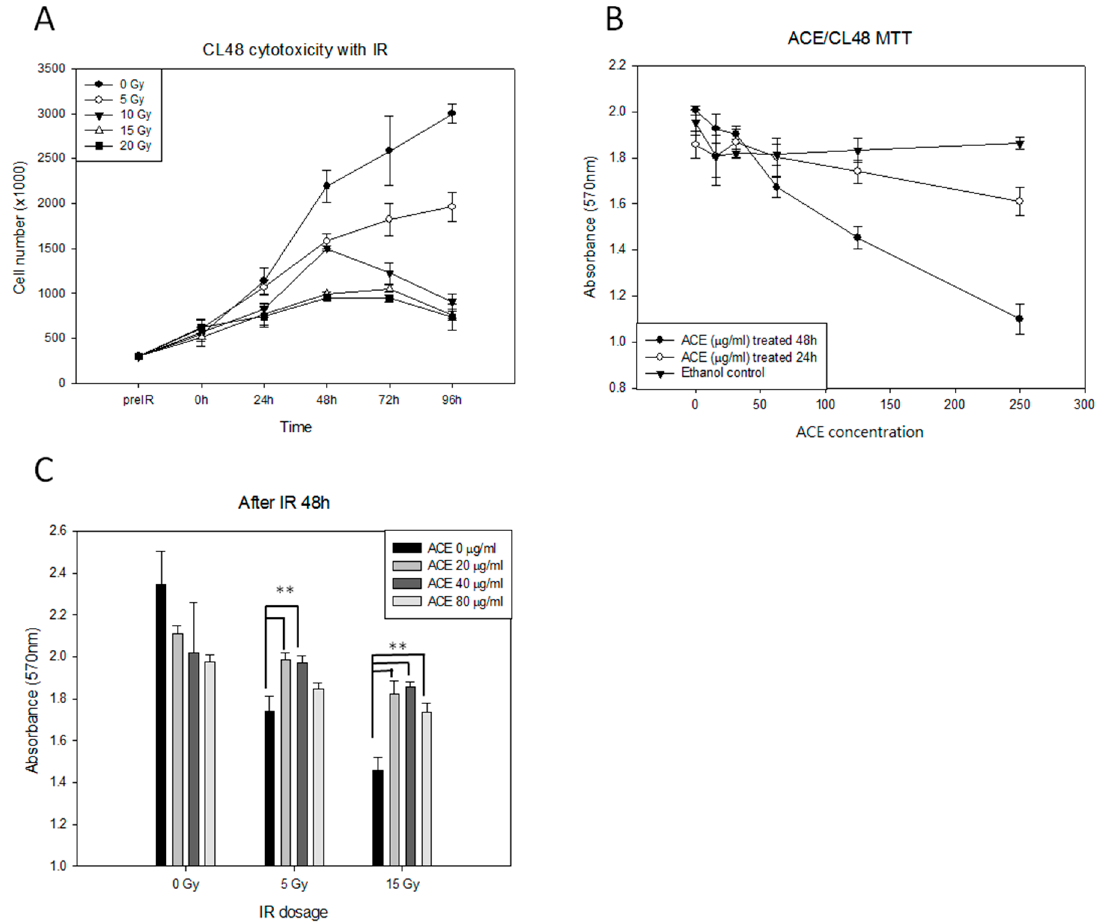
Figure 1. The protective effects of Antrodia cinnamomea extract (ACE) against irradiation in human normal liver CL48 cells. ( A ) Cytotoxicity of irradiation in CL48. Cells were treated with different dosages (0, 5, 10, 15, and 20 Gy) of irradiation and counted by hemocytometer at intervals as indicated. ( B ) Determination of the optimal ACE dosages. Cells were treated with different concentrations of ACE for 24 h or 48 h, followed by 3-(4,5-dimethylthiazol-2-yl)-2,5-diphenyltetrazolium bromide (MTT) assay for cell survival. For the control group, the same concentrations of ethanol were used for each ACE treatment experiment. ( C ) The protective effect of ACE against irradiation. Cells were pre-treated with different concentrations of ACE for 16 h followed by various dosages of irradiation; they were evaluated by MTT assay 48 h later. Cell survival was evaluated by MTT assay. Results were obtained from three independent experiments; each experiment was done in triplicate. **, p < 0.01, as compared with the control group.